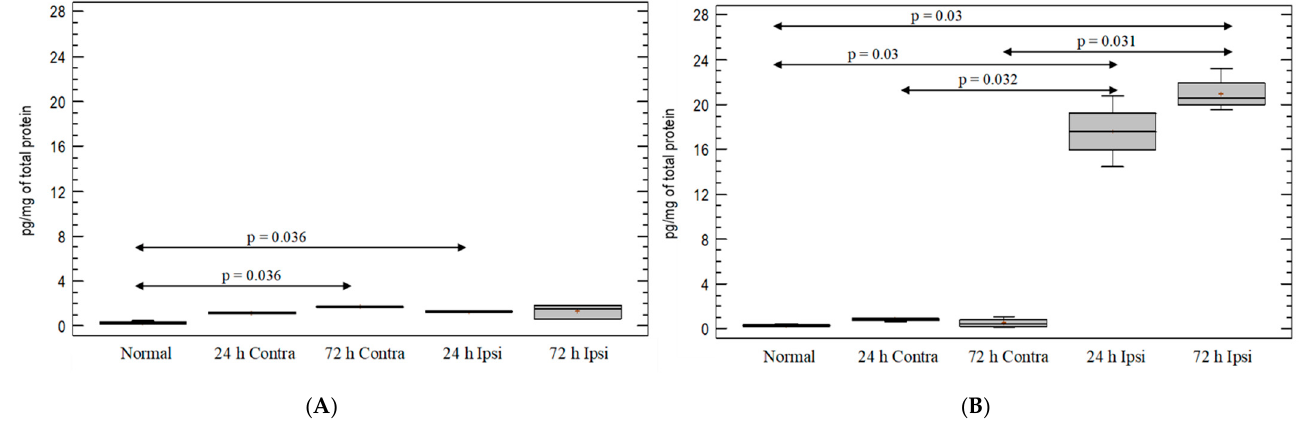
Figure 5. CXCL2 expression in mouse brain after ( A ) PBS injection and ( B ) KA injection. Brains were collected 24 h and 72 h postinjection. Ipsi—ipsilateral hemisphere; Contra—contralateral hemisphere; Normal—control animals without any injection.